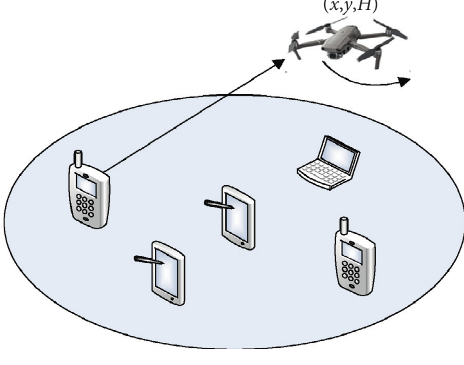
Figure 1: System